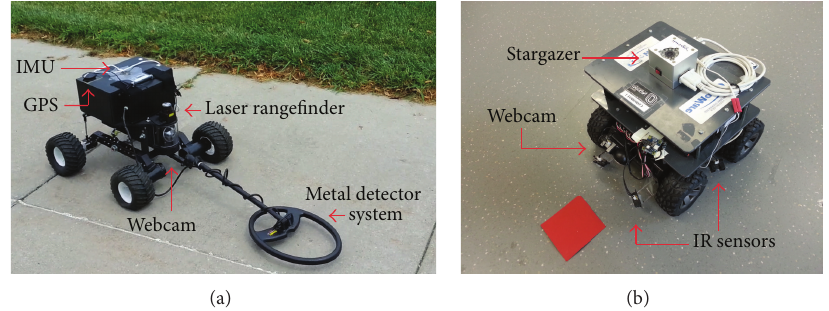
Figure 2: Robots used in COMRADES along with their sensors. (a) Explorer robot, (b) Corobot robot.